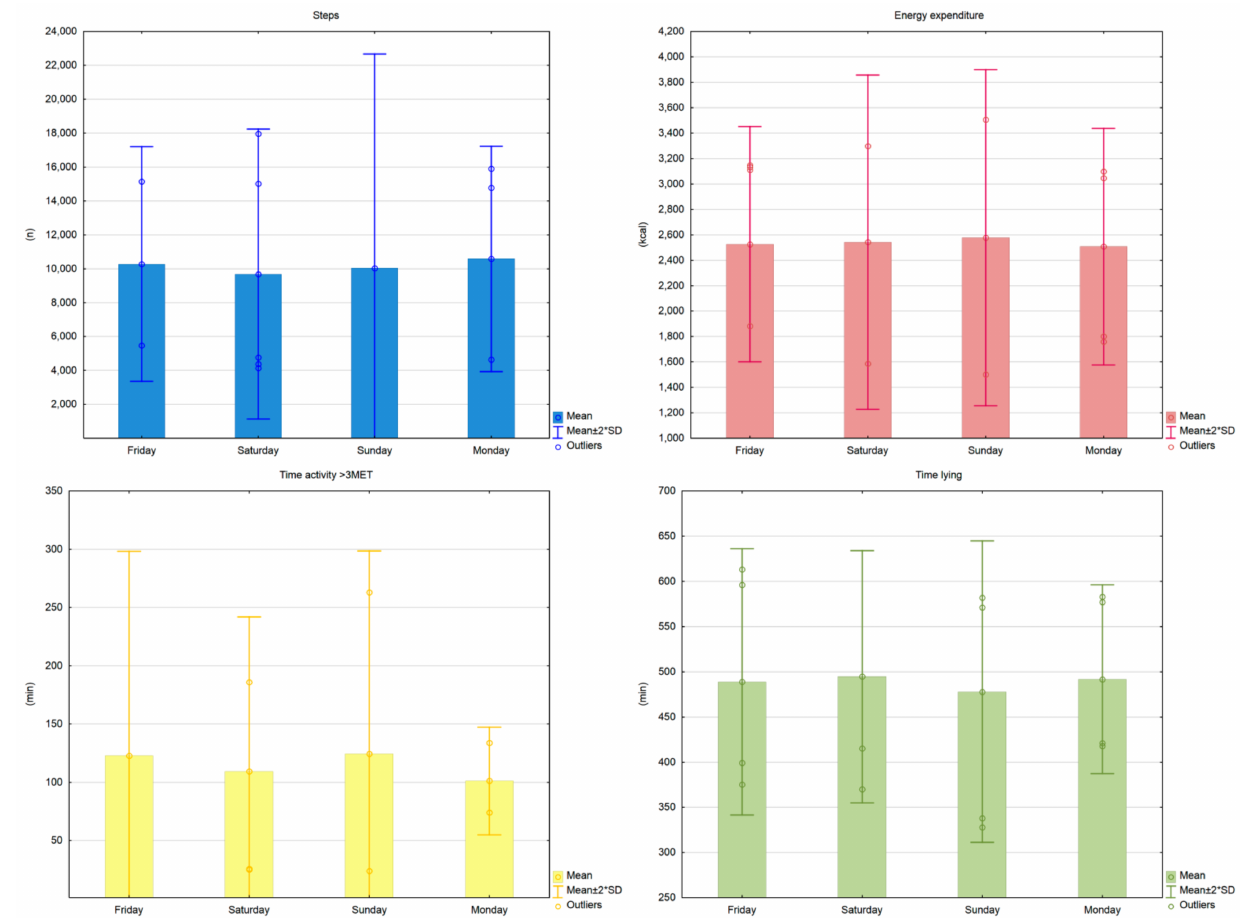
Figure 2. Examined parameters on consecutive days of the